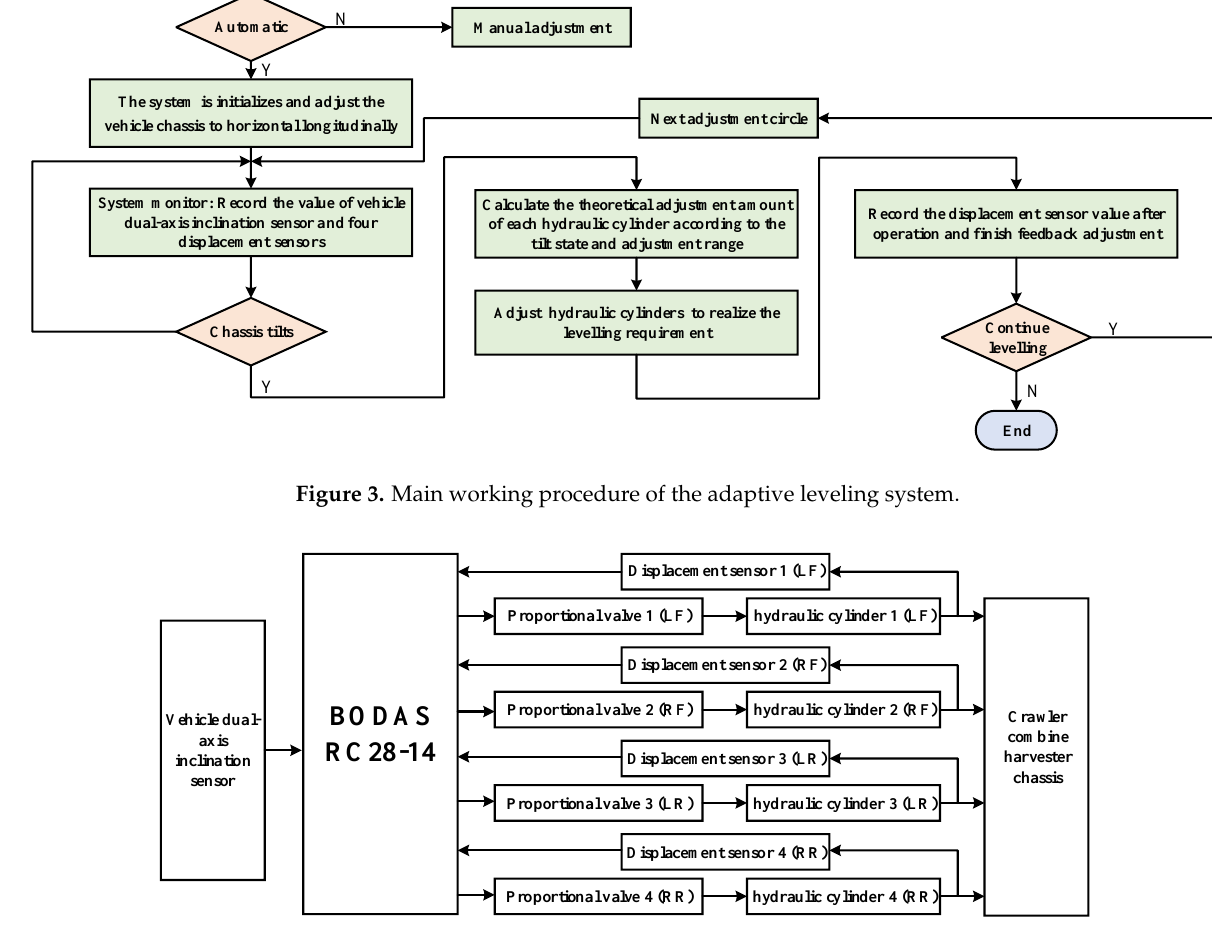
Figure 3. Main working procedure of the adaptive leveling system.